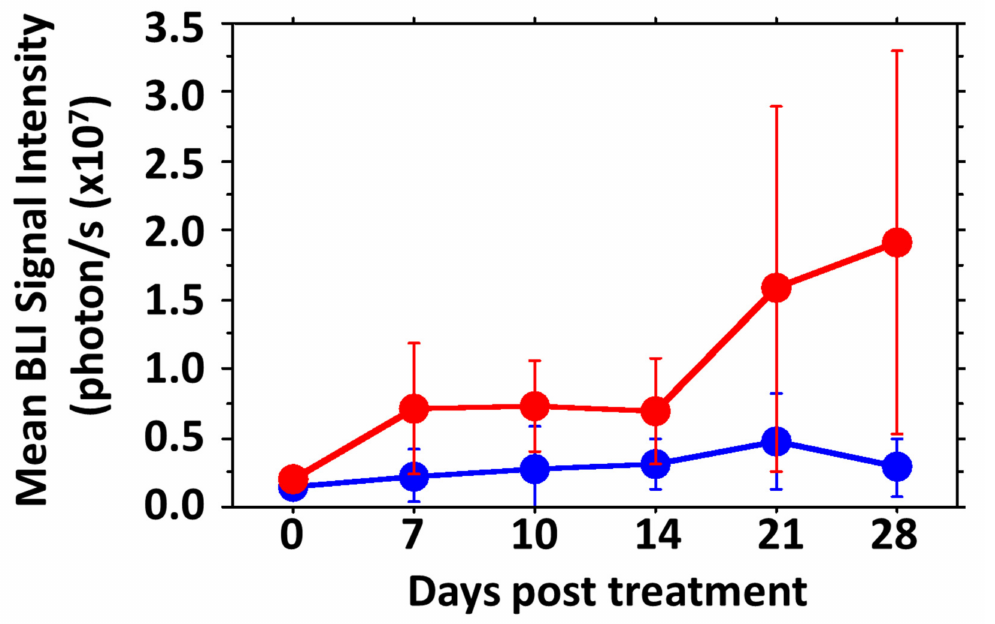
Figure 9. Growth curves for groups of orthotopic RENCA-luc tumors. Saline controls (red, n = 7) are compared with OXi6197 (35 mg/kg twice weekly, blue n = 4; an outlier is excluded from the group presentation). Mean tumor BLI signal as a surrogate for tumor volume was not significantly different at any given time point ( p > 0.05), but overall the treated tumors were significantly smaller (based on light emission) than controls over the first 28 days after treatment was initiated ( p < 0.003). Compared to baseline, control tumors were significantly larger after 21 days ( p = 0.0176), while tumors treated with OXi6197 required 35 days to be significantly larger ( p = 0.0035). Curves for individual tumors are presented in Supplementary Figure